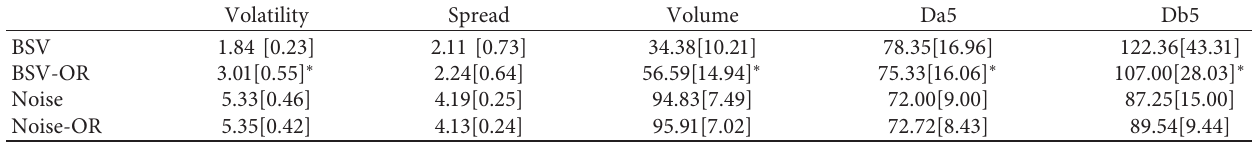
Table 3: Market quality measures with BSV and noise